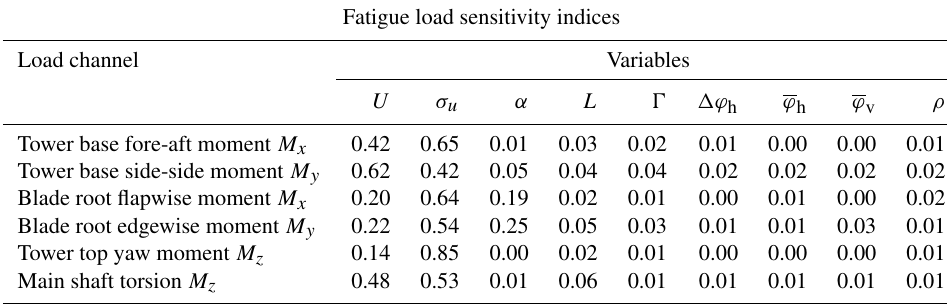
Table 3. PCE-based Sobol sensitivity indices for the high-fidelity load database variable